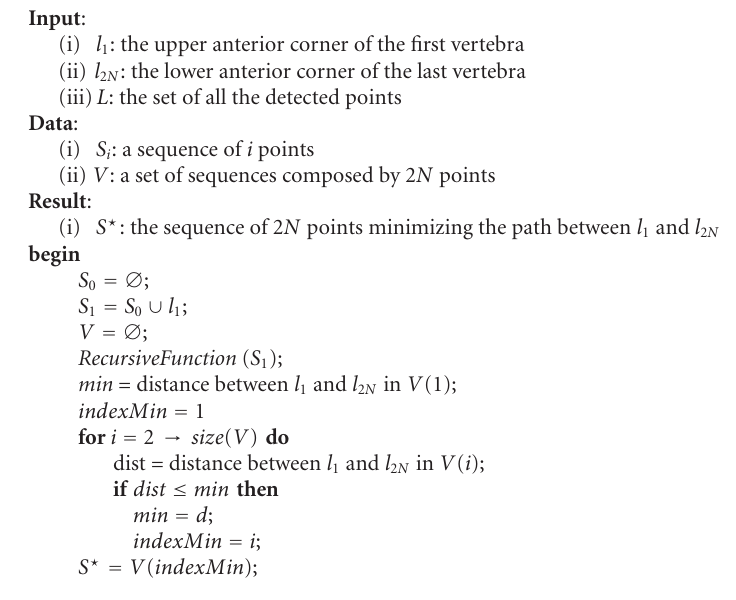
Algorithm 1: Determine the sequence of the vertebra